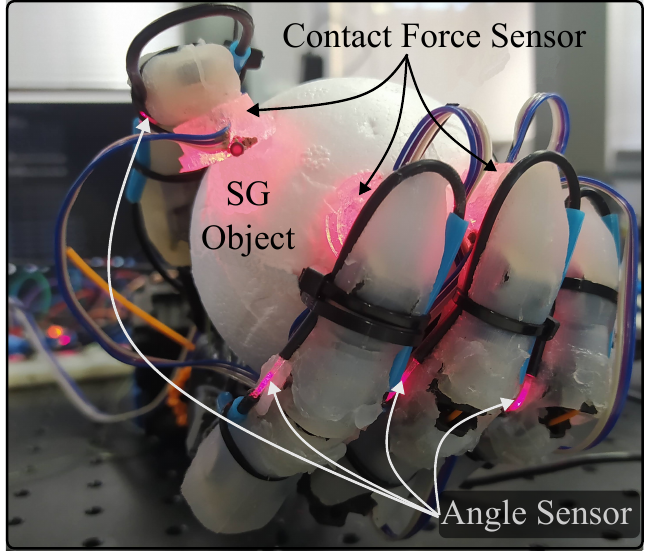
Figure 8. Prosthesis with the soft-sensor integrated, holding one object for the